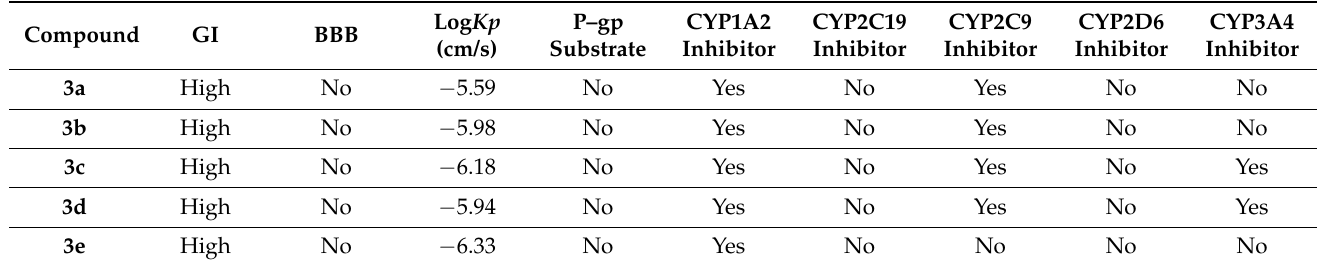
Table 2. Predicted pharmacokinetic parameters of investigated compounds by SwissADME server.